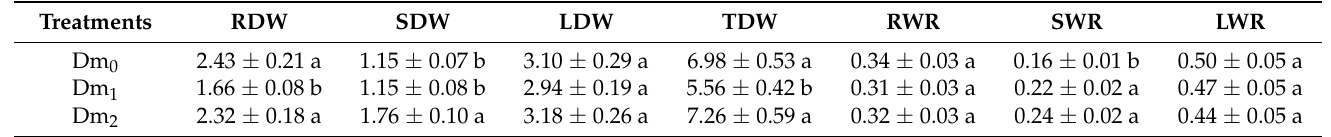
Table 3. The effects of different fertigation treatments (Dm 0 —standard nutrient solution, Dm 1 —raw leachate treatment, and Dm 2 —raw leachate blended with H 2 O 2 treatment) on root, stem, leaf, and total plant dry weight (RDW, SDW, LDW, and TDW, respectively) (g), relative root weight ratio (RWR), stem weight ratio (SWR), and leaf weight ratio (LWR) ( − ) in D. marginata plants at the end of the experiment. The results are expressed as means ± standard deviation ( n = 4). In each column, the same letters indicate non-significant differences ( p < 0.05).